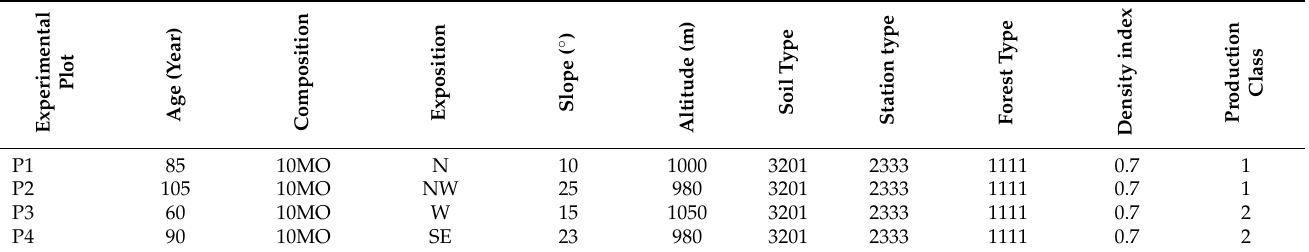
Table 1. Data identification of the component stands where they were installed for assessing standing- tree wood density by microdrilling.